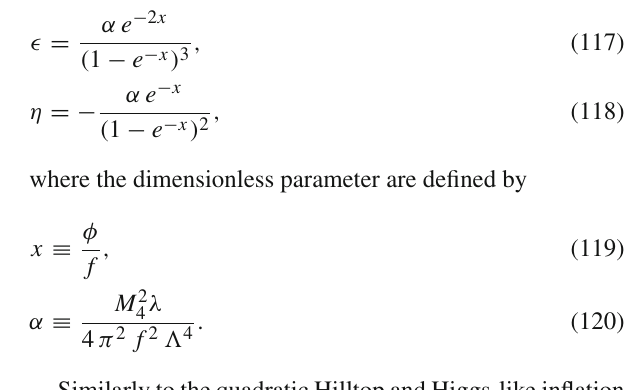
Table 10 Summary of the allowed range for the number of e -folds for each EoS parameter w re when the dimensionless parameter α is fixed to be α = 0 . 0115 and M 5 = 10 12